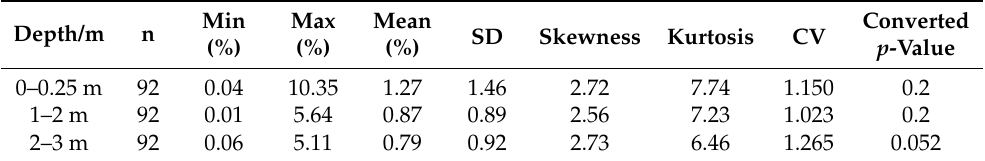
Table 1. Descriptive statistical analysis of soil